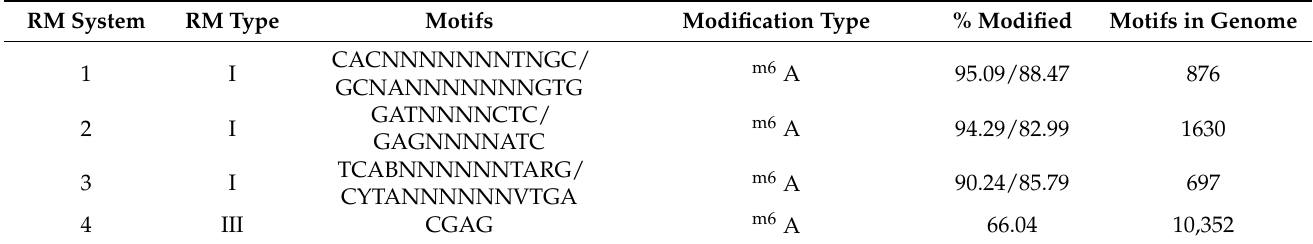
Table 1. Methylome data of P. thermosuccinogenes DSM 5809. The percentage of these methylated recognition sites (motifs) in the genome denoted as % Modified. Motifs in the genome represent the number of times each motif appears in the genome. Methylated m6 A bases are in bold. Nucleotide code: B (C, G, or T), D (A, G, or T), N (any base), R (A or G), V (A, C, or G), and Y (C or T). P. thermosuccinogenes DSM 5809 genome sequence was assembled using data from Illumina HiSeq and Pacbio sequencing